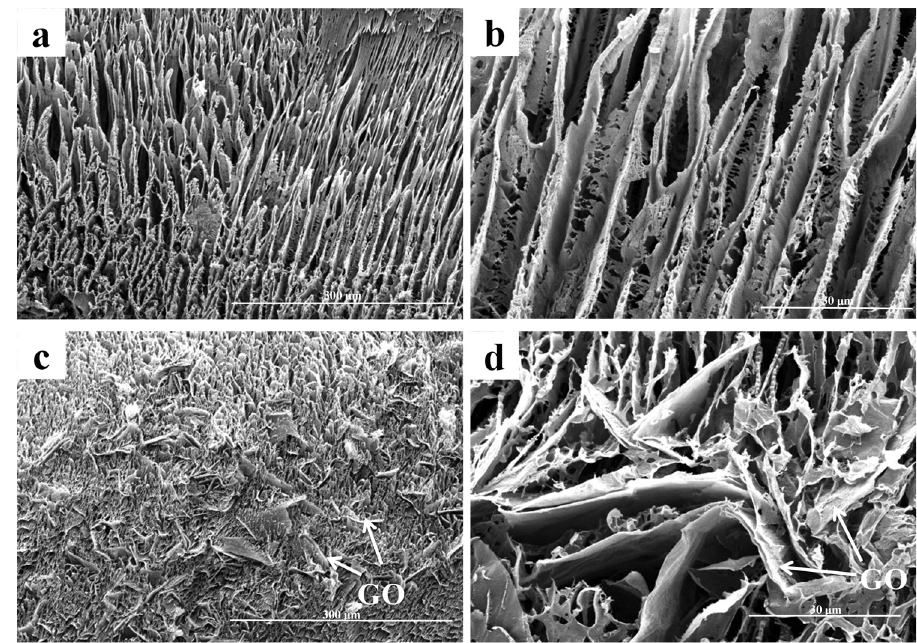
Figure 3: SEM photographs ( a and b ) PVA aerogels; ( c and d ) GO/PVA